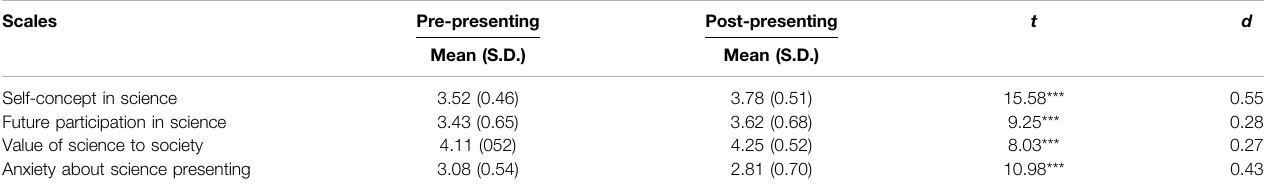
TABLE 4 | Current presenters ’ attitudes towards science before and after presenting on 5-point, Likert-type scaled items, tested with paired sample t -test for the mean scores of current presenters ( n = 690).